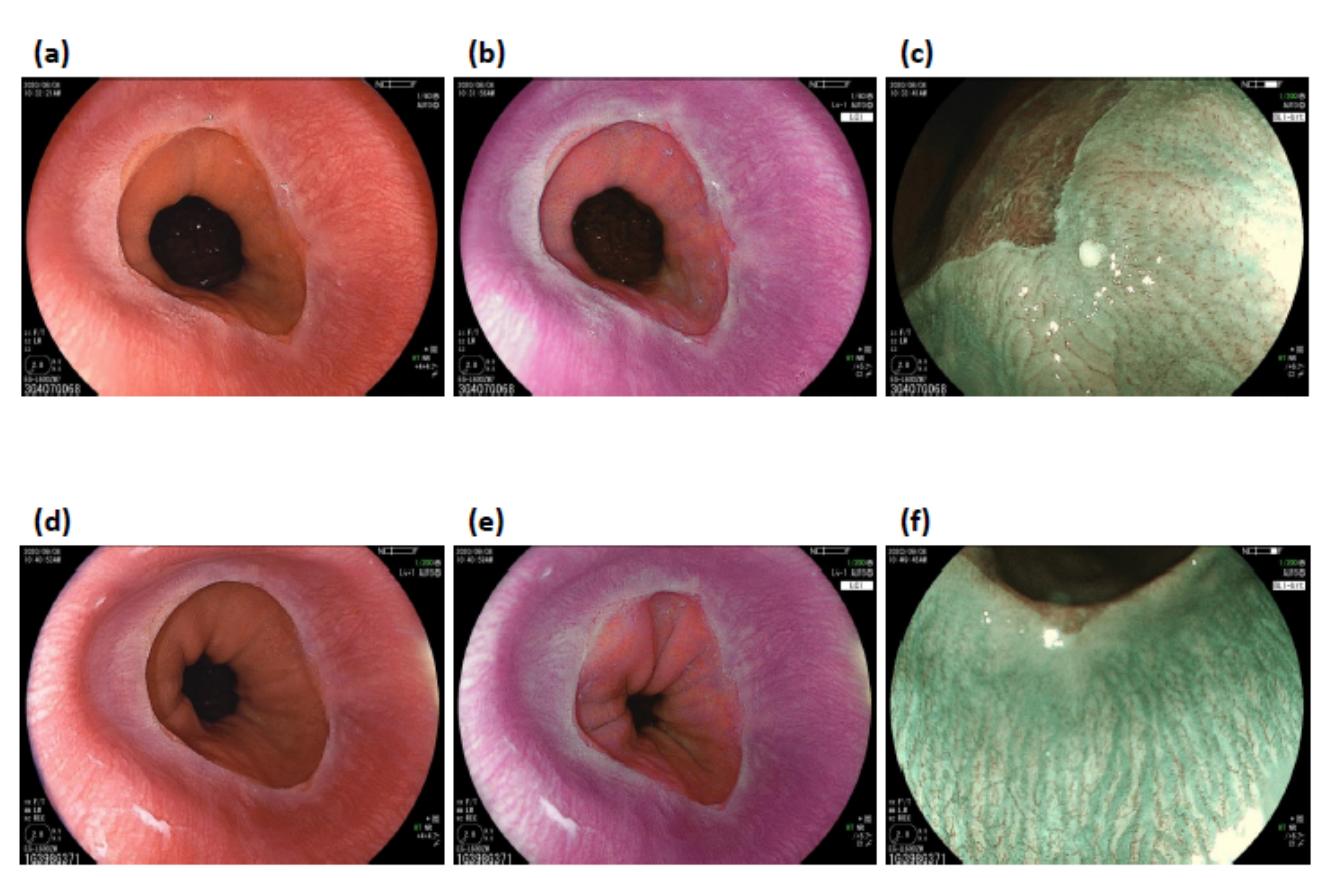
Figure 1. A 28-year-old male patient suffered from postprandial heartburn. The F-scale, which is a questionnaire scoring system for GERD, showed 27 points in this patient, which suggests reflux esophagitis since the result is higher than 8 points. WLE shows minimal changes in a white turbidity area with invisibility of palisade vessels along with slightly irregular z-line ( a ). LCI can visualize the minimal changes more clearly than WLE ( b ). BLI-ME demonstrates an increased number of dilated microvessels (IPCLs) in the white turbidity area ( c ). After taking a proton pump inhibitor for 4 weeks, the F-scale score decreased from 27 to 5 points. Color changes in white turbidity reduced on both WLE and LCI images (( d , e ), respectively). BLI-ME shows that palisade vessels are visible and the severity of increased and dilated IPCLs reduces ( f ).